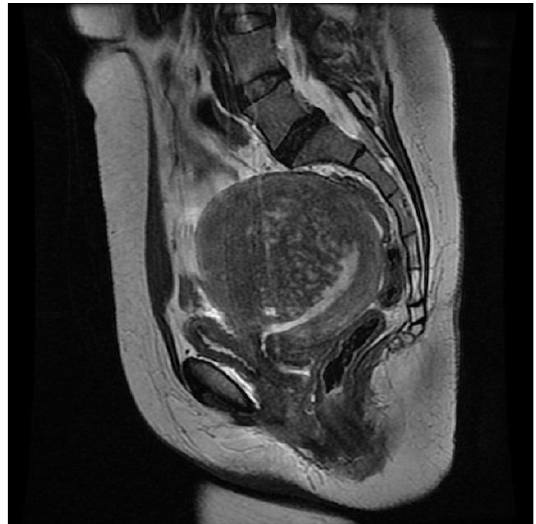
Figure 8. Pseudo-widening of the endometrium: sagittal T2-weighted image showing an asymmet- rically thickened junctional zone (diffuse adenomyosis) with striated high-signal-intensity areas radiating from the endometrium toward the myometrium, a feature that simulates invasion by an endometrial carcinoma.